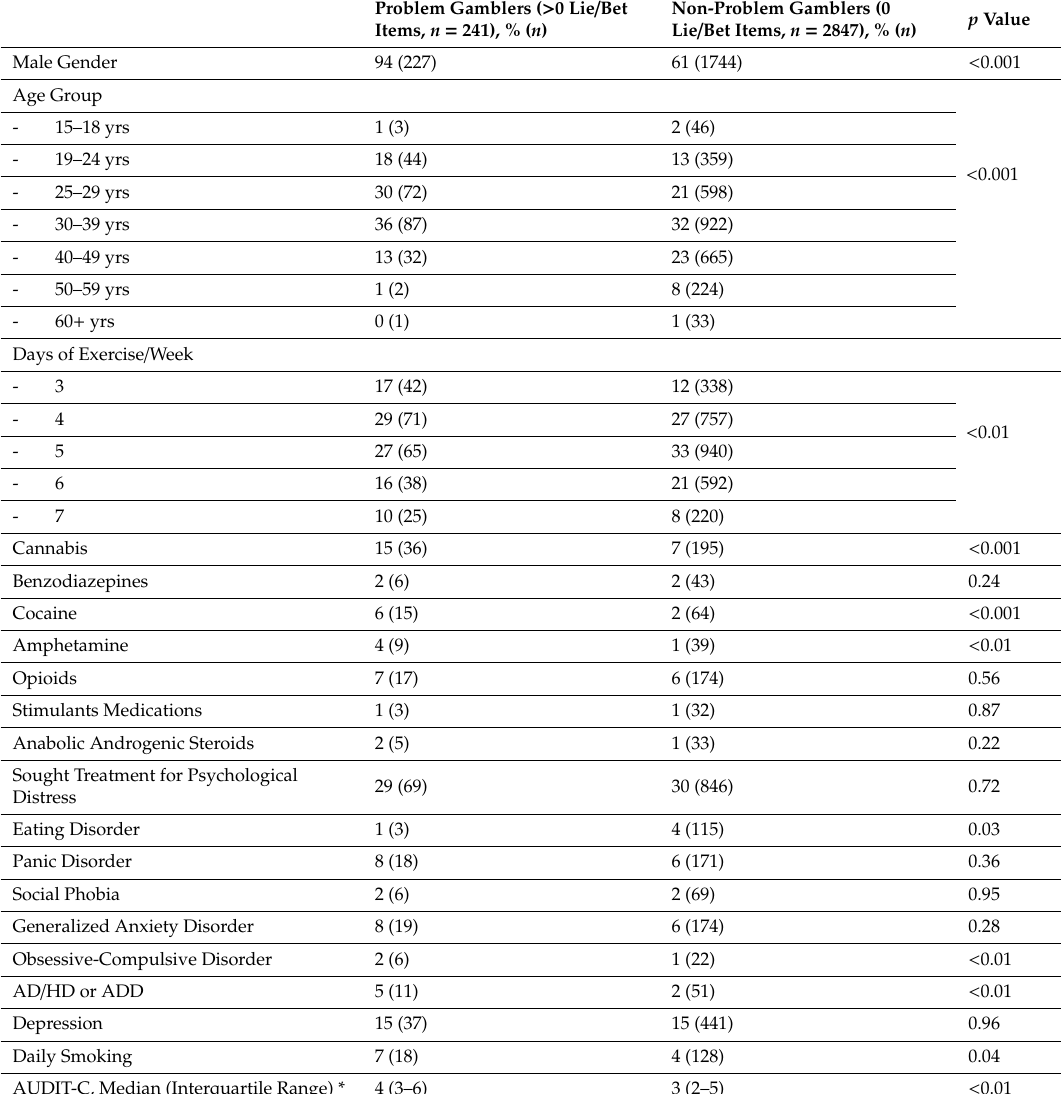
Table 1. Comparison of problem gamblers and non-problem gamblers. Demographic characteristics, substance use and psychological